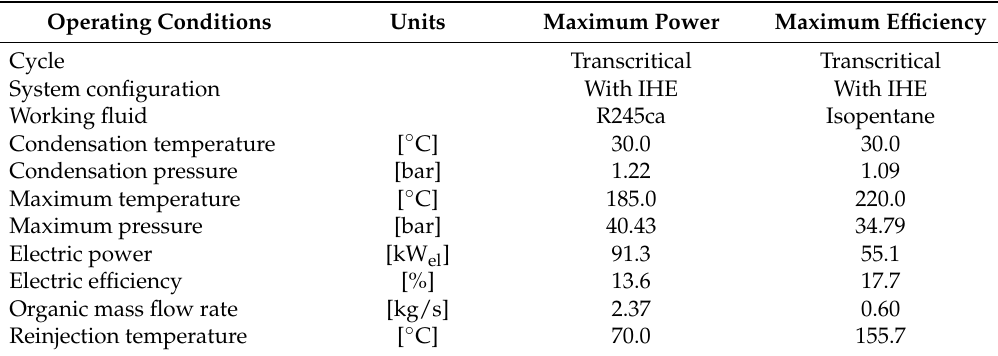
Figure 11. Typical electric load profiles for a single apartment in the investigated area during winter, intermediate, and summer season.